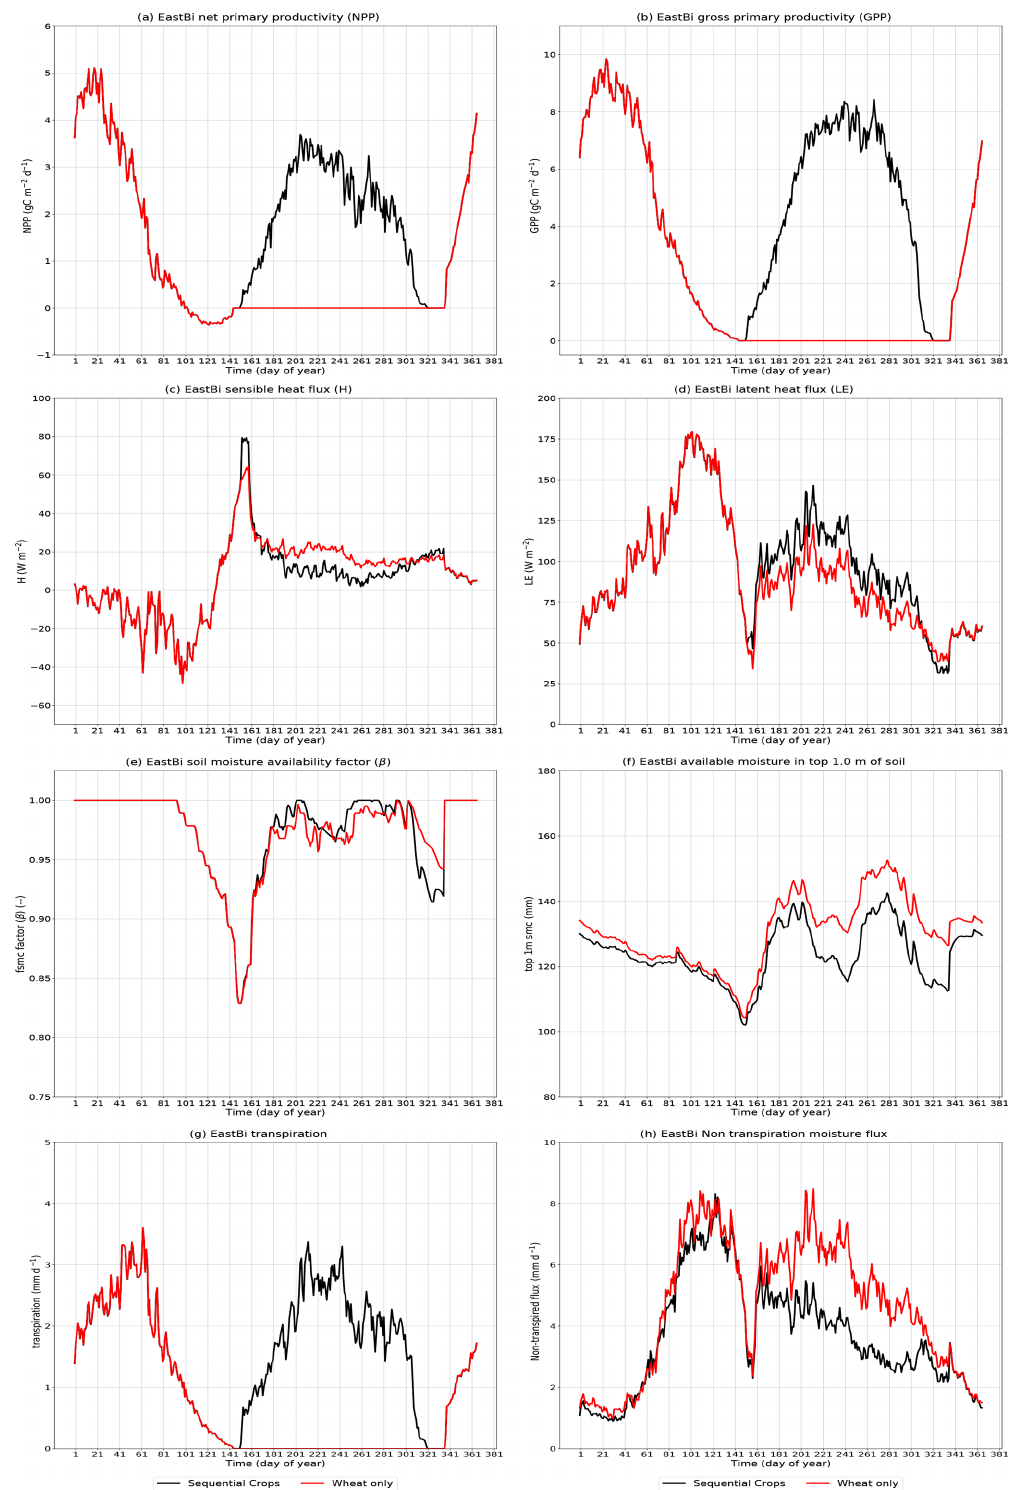
Figure B6. Annual climatology of fluxes (in day of year) for EastBi for India-sequential (black) and India-single (red): carbon fluxes: NPP (a) and GPP (b) . Heat fluxes: sensible heat H (c) and latent heat LE (d) . Soil moisture variables: β (e) and soil moisture availability in the top 1m of soil (f) . Moisture fluxes: evapotranspiration (g) and non-evapotranspiration moisture fluxes (h)